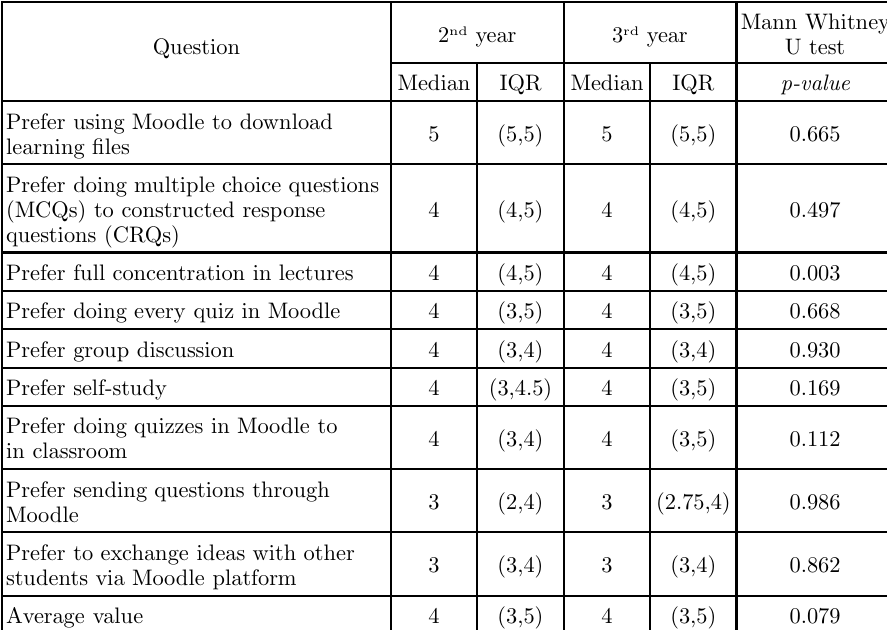
Table 4. SPBS in Moodle